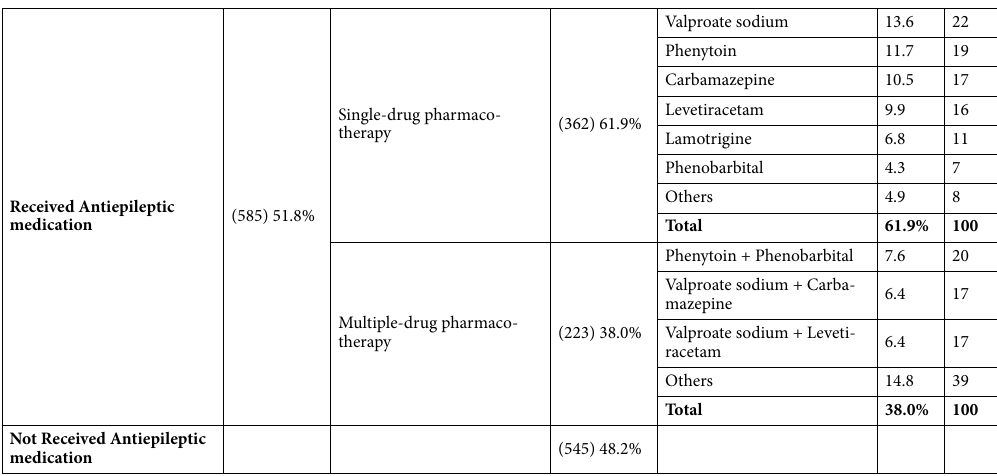
Table 4. Epilepsy Pharmacotherapeutics in